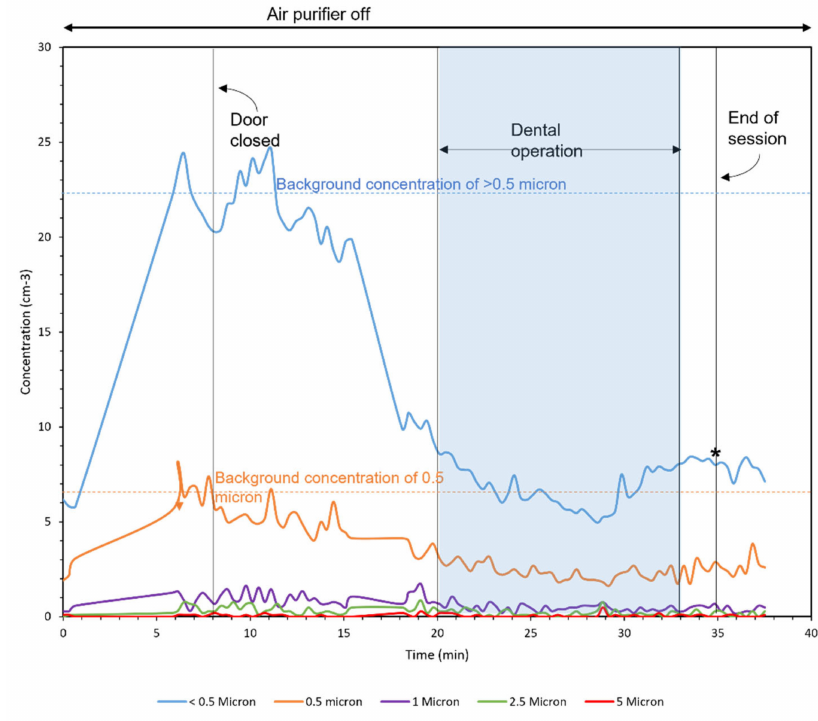
Figure 9. Operation 2 in room A (Large room). Asterisks in the figure represent the moments that the door was